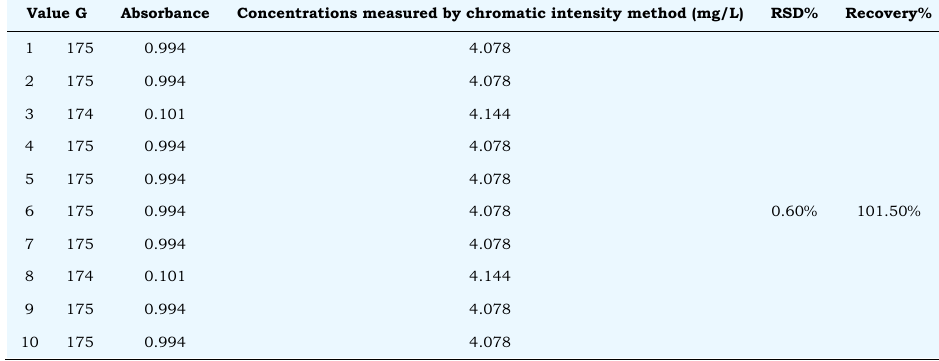
Table 1 The congruence results of the RGB method Value G Absorbance Concentrations measured by chromatic intensity method